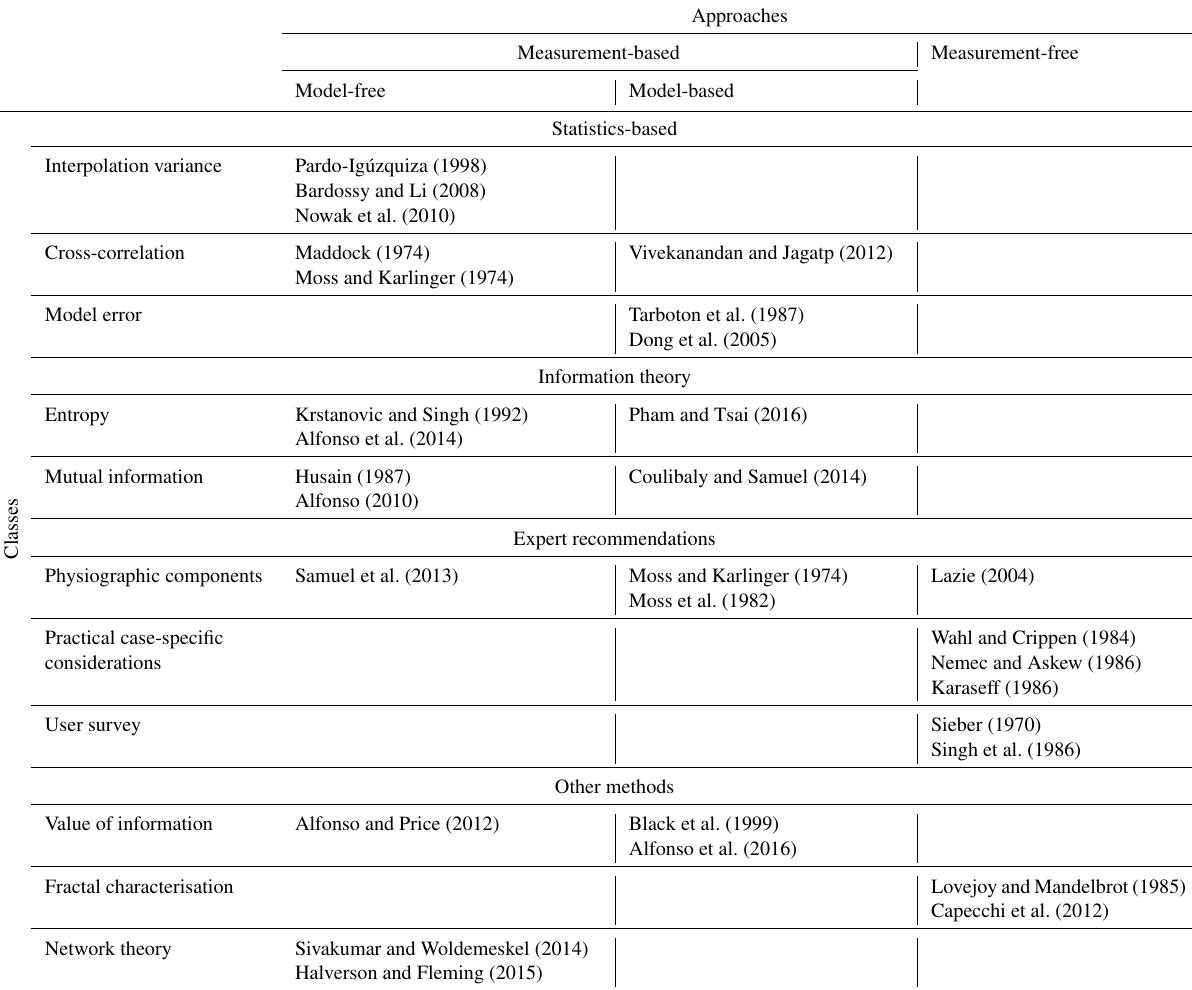
Table 2. Classification of sensor network design criteria including recommended